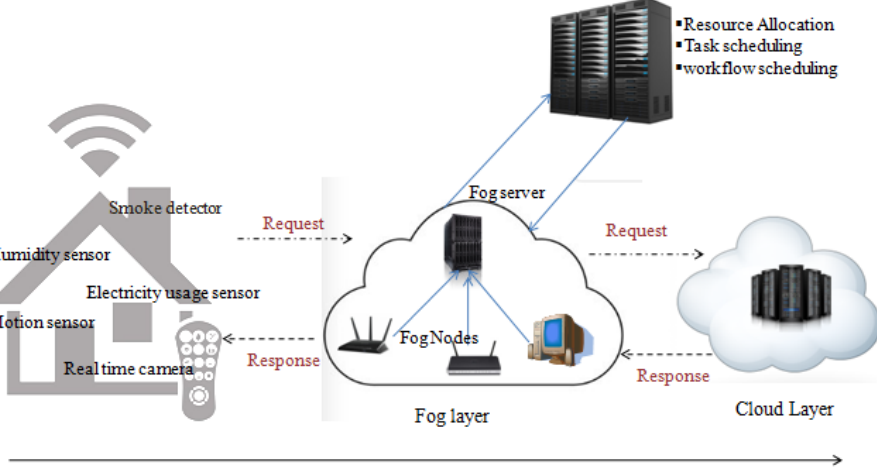
Figure 1. Fog–cloud architecture for smart